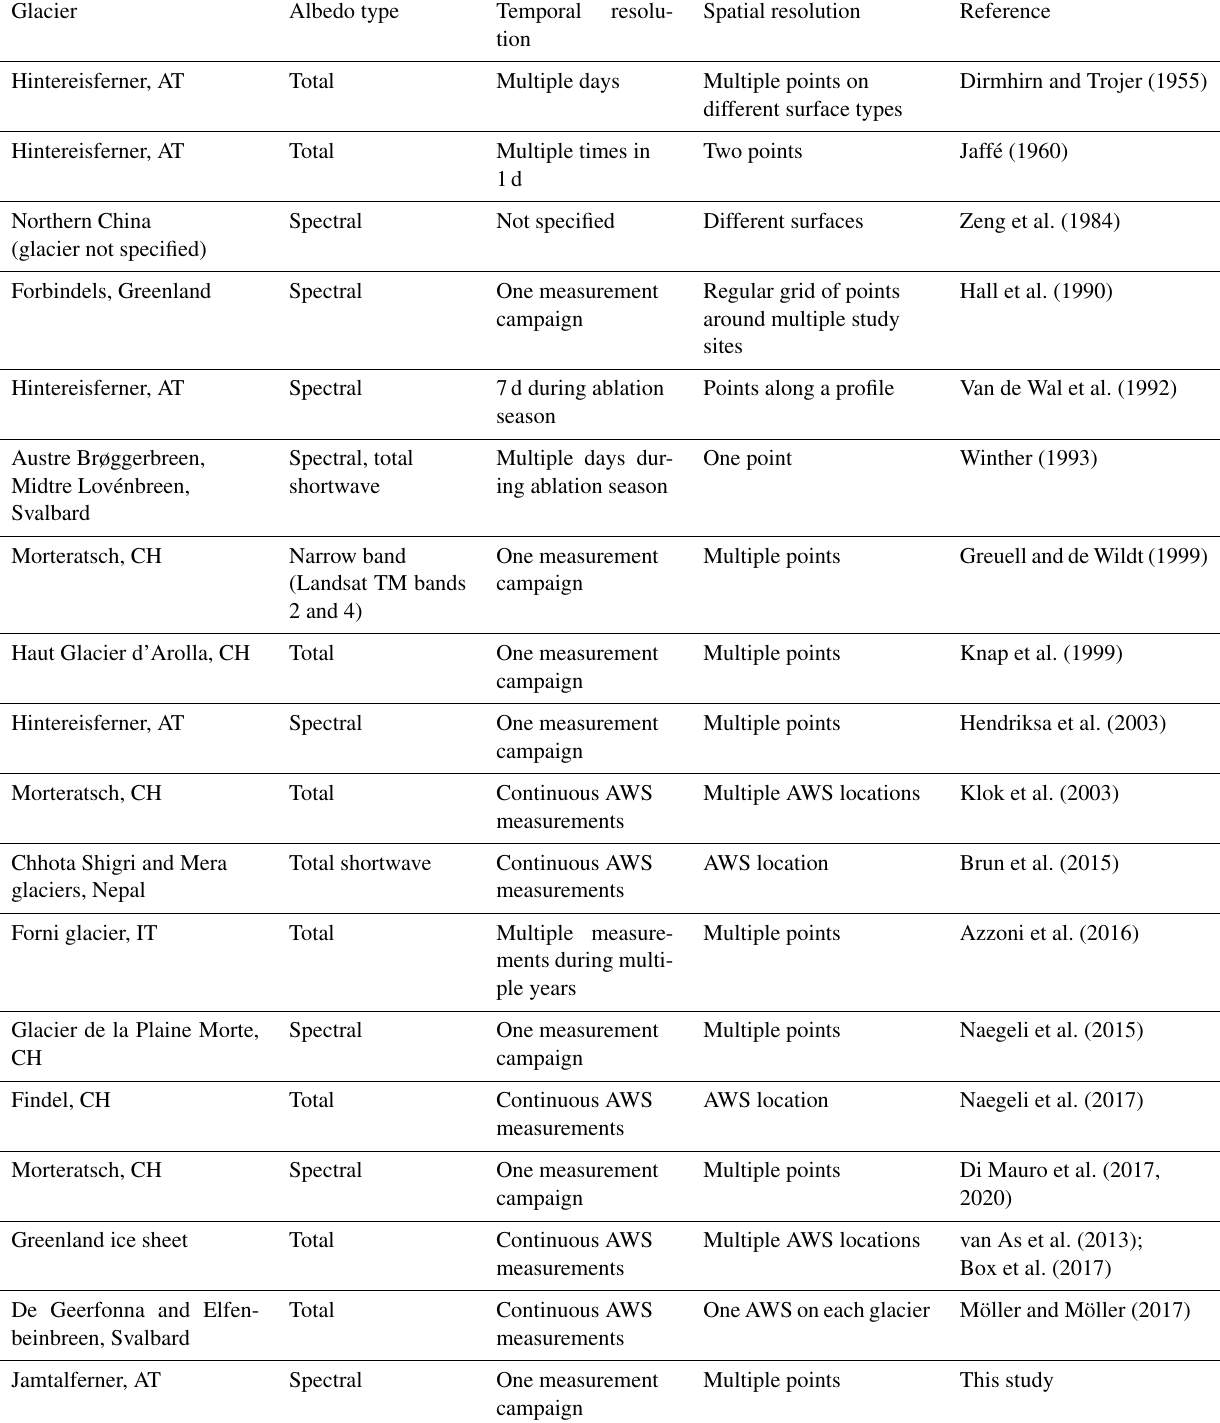
Table 1. Overview of measurements of bare-ice reflectance properties on mountain glaciers. AT denotes Austria; CH denotes Switzerland; IT denotes